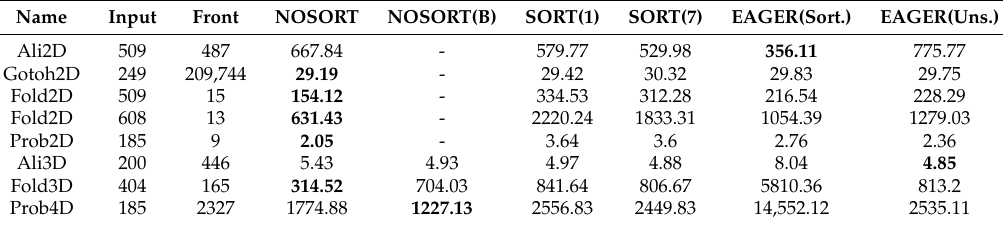
Table 6. Summary of benchmarks of all applications. Input and front sizes are given. We compare the full runtimes in seconds (s) for three strategies in overall six variants: the strategy (NOSORT) using pf nosort , its multidimensional variant NOSORT(B) using the specialized sorted case SORT(7), using Merge-in-place with pf sort , as well as EAGER (Sorted), using Merge 1 and Merge 2, and, finally, EAGER(Unsorted), using Merge 3. No algorithm can win in all